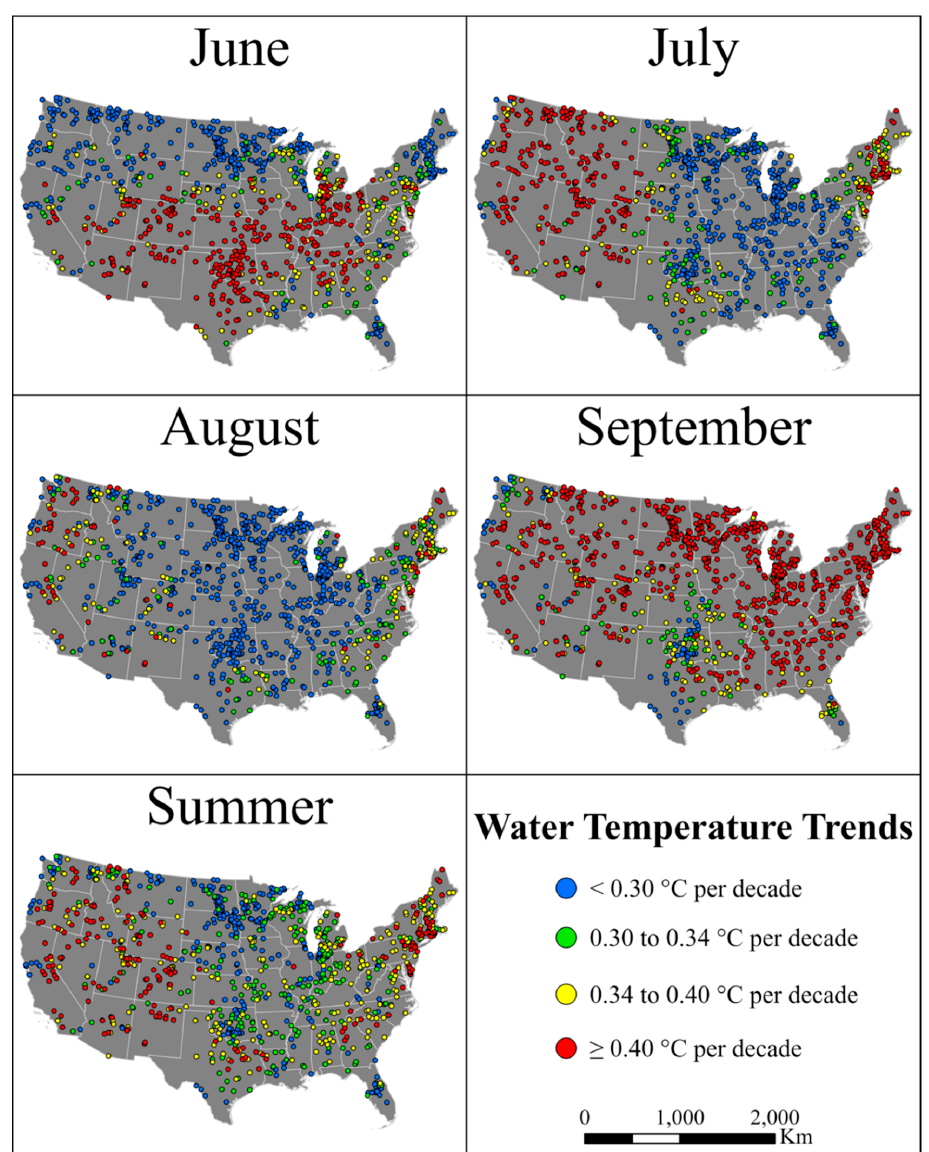
Figure 4. Rates of temperature change in 1033 United States lakes during the time period 1981–2018.